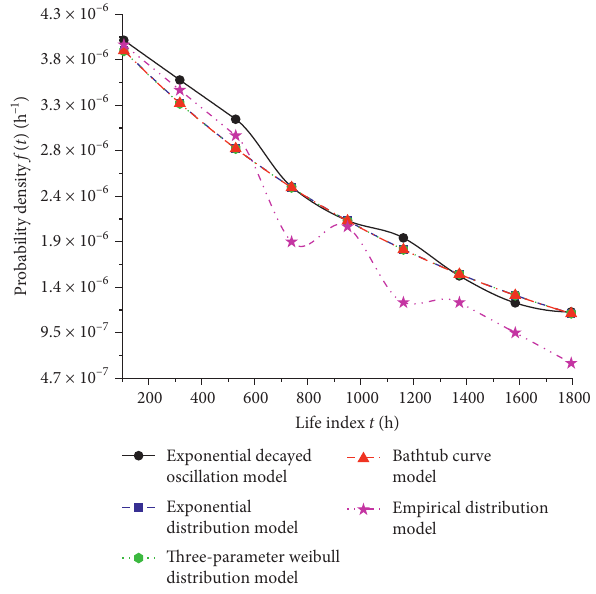
Figure 37: Comparison of probability Table 2: Comparison of root mean square error.